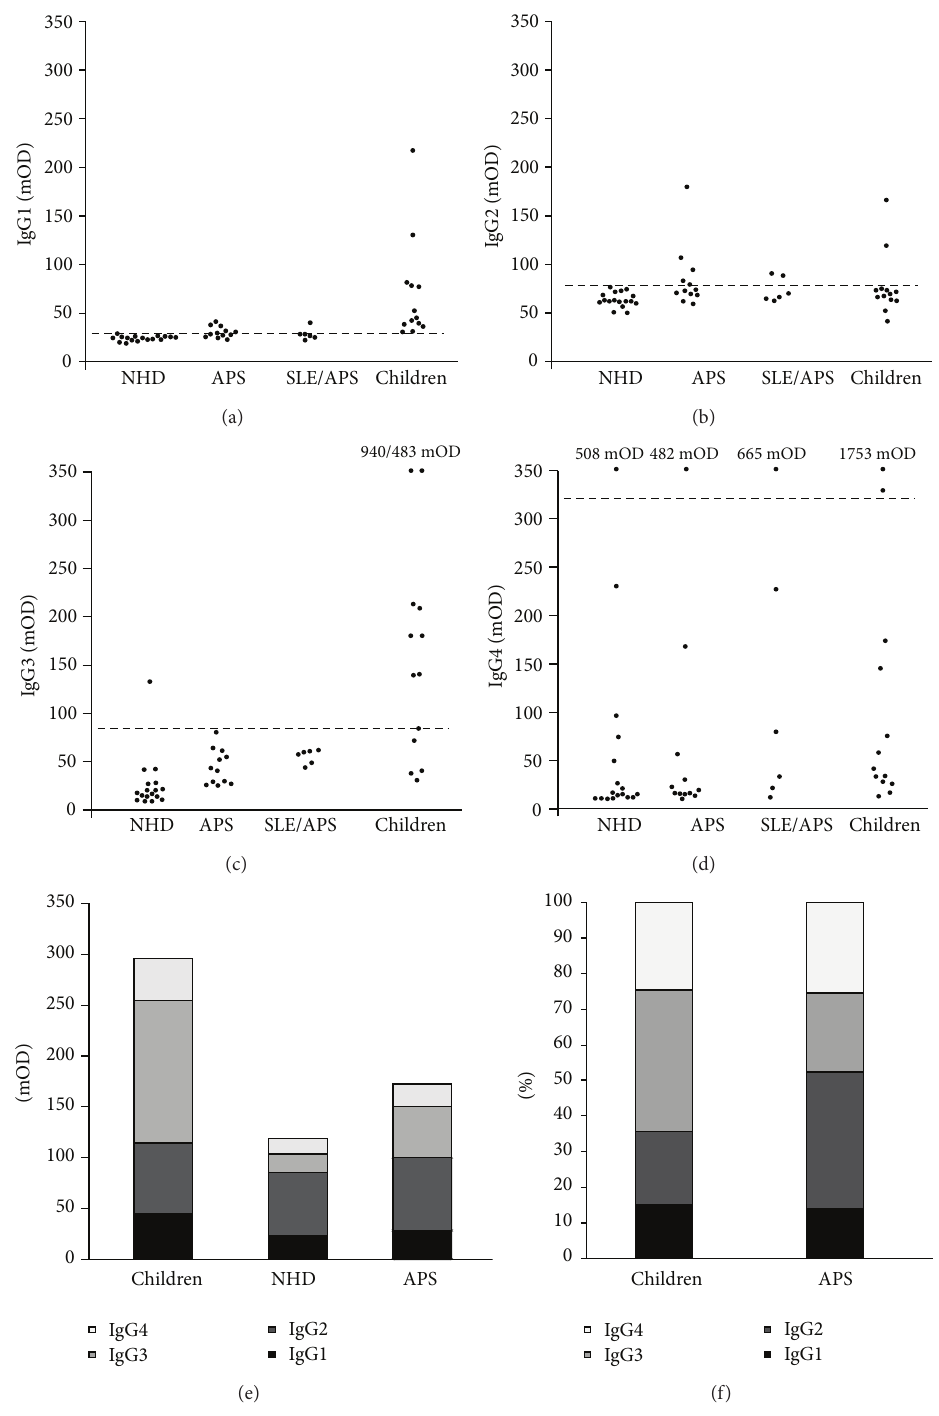
Figure2:mODvaluesofanti- 𝛽 2GP1-IgG1(a),anti- 𝛽 2GP1-IgG2(b),anti- 𝛽 2GP1-IgG3(c),andanti- 𝛽 2GP1-IgG4(d)inNHD,PAPS,SLE/APS, and children. The horizontal lines represent the cut-off for seropositivity of the corresponding anti- 𝛽 2GP IgG-subclass ( > mean mOD [ NHD ] + 2 × SD [ NHD ] ); NHD = normal healthy donor; PAPS = primary antiphospholipid syndrome; SLE/APS = antiphospholipid syndrome with systemic lupus erythematosus; OD = optical density. Median OD values of the anti- 𝛽 2GP1-IgG subclasses in the study cohorts (e). Regarding the anti- 𝛽 2GP1-IgG subclass-distribution within the cohorts, children showed a significantly higher contribution of IgG3 than IgG1 and IgG2. Patients with antiphospholipid syndrome (APS) showed a higher content of anti- 𝛽 2GP1-IgG2 than -IgG1 and -IgG3. NHD showed a higher contribution of anti- 𝛽 2GP1-IgG2 than -IgG1, -IgG3, and -IgG4. The columns represent the median OD values of IgG1, IgG2, IgG3, and IgG4 in the cohorts. OD = optical density; NHD = normal healthy donor. Percentage distribution of anti- 𝛽 2GP1-IgG subclasses in children and patients with APS (f). Children harbour significantly less anti- 𝛽 2GP1-IgG2 than patients with APS but more anti- 𝛽 2GP1-IgG3. APS = antiphospholipid